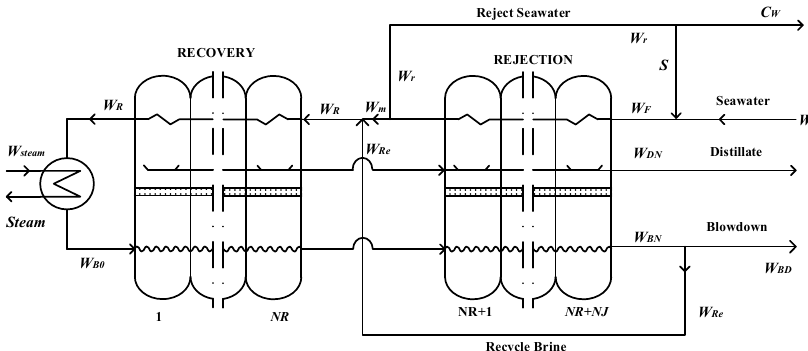
Figure 1. Multistage flash (MSF) desalination system.